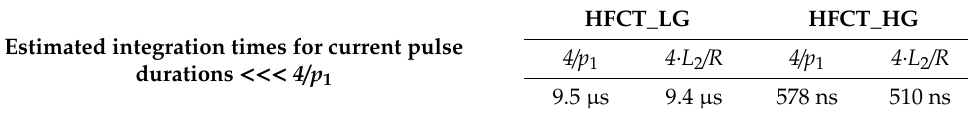
Table 3. Estimation of integration times for charge calculation using the double time integral of the measured voltage.